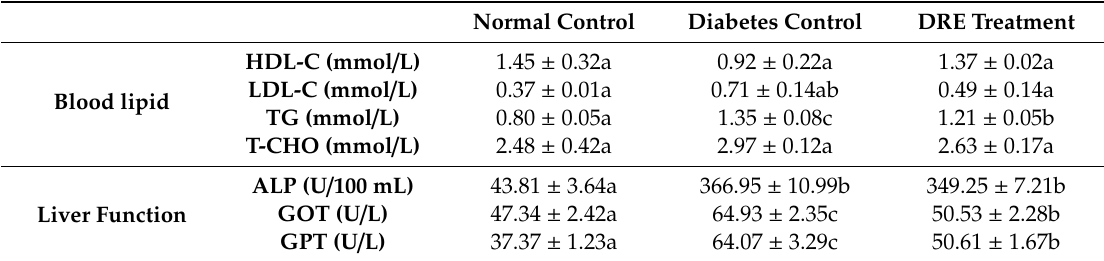
Table 4. Lipids profiles and liver function parameters in the experimental